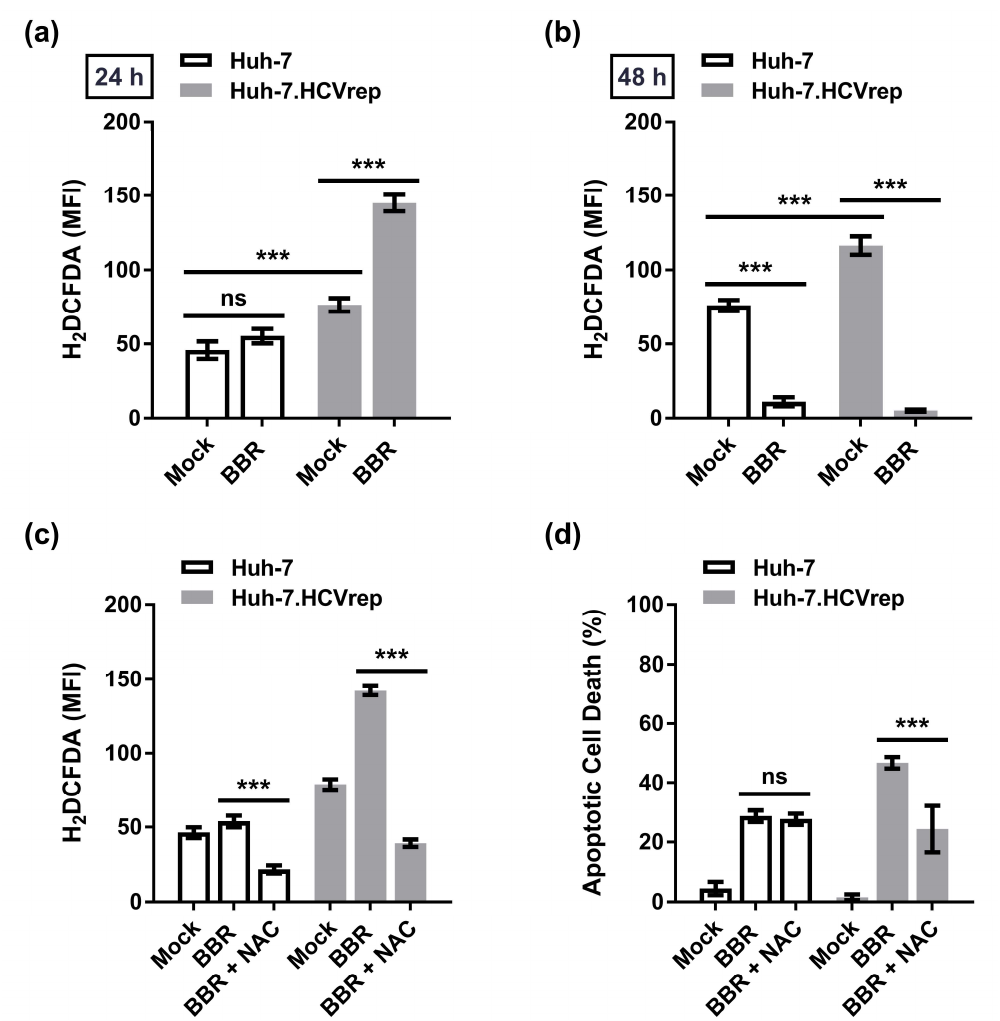
Figure 3. N-acetyl-cysteine (NAC) attenuated berberine (BBR)-induced cell death in the Huh-7 cells Figure 3 carrying hepatitis C virus (HCV) subgenomic replicon RNA. Huh-7 and Huh-7.HCVrep cells were seeded in 6-well plates and treated with or without 100 µ M BBR for ( a ) 24 or ( b ) 48 h. Cells were then stained with 20 µ M 2 (cid:48) ,7 (cid:48) -dichlorodihydrofluorescein diacetate (H 2 DCFDA) for flow cytometry analysis. For reactive oxygen species (ROS) inhibition analysis, cells seeded in 6-well plates were pretreated with 10 mM NAC for 48 h before treatment with 100 µ M BBR for 24 h and subjected to ( c ) H 2 DCFDA staining or ( d ) Annexin V / Propidium Iodide (PI) staining. Results are shown as means ± SD from three independent repeats for all experiments. *** p < 0.001; ns = not